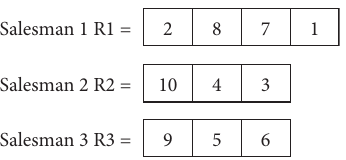
Figure 1: Direct-route encoding for